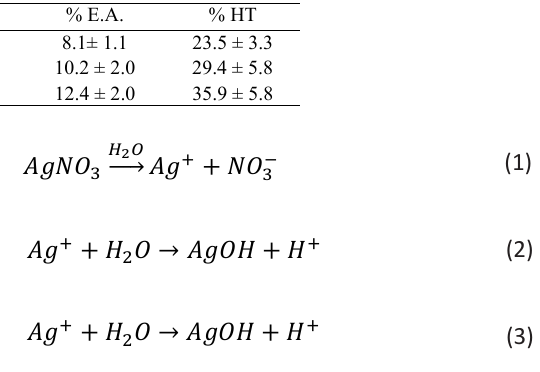
Table 2. Hydrolysable tannins determined as ellagic acid (E.A.) and hydrolysable tannins